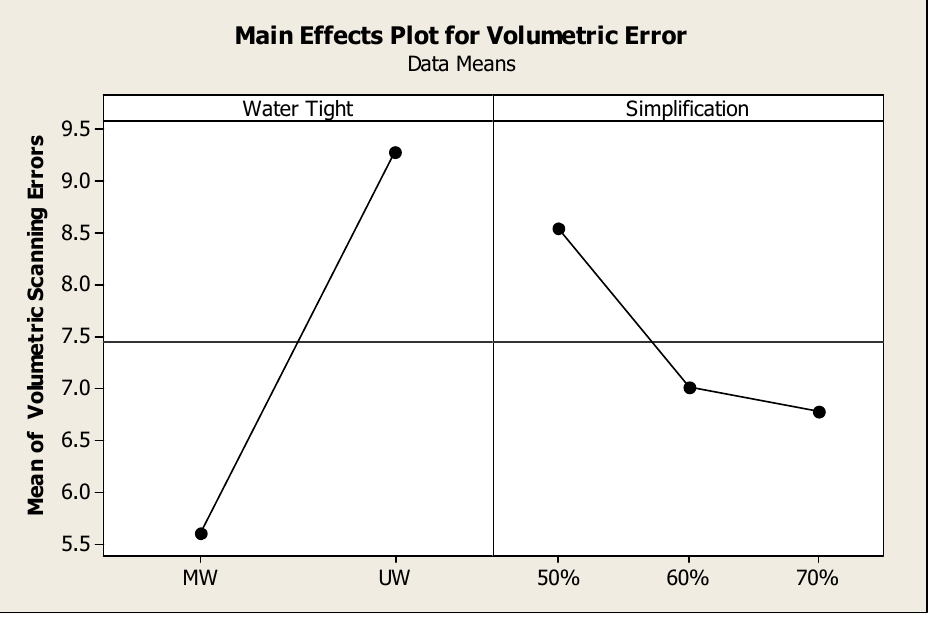
Table 4. ANOVA for volumetric error (mode D).